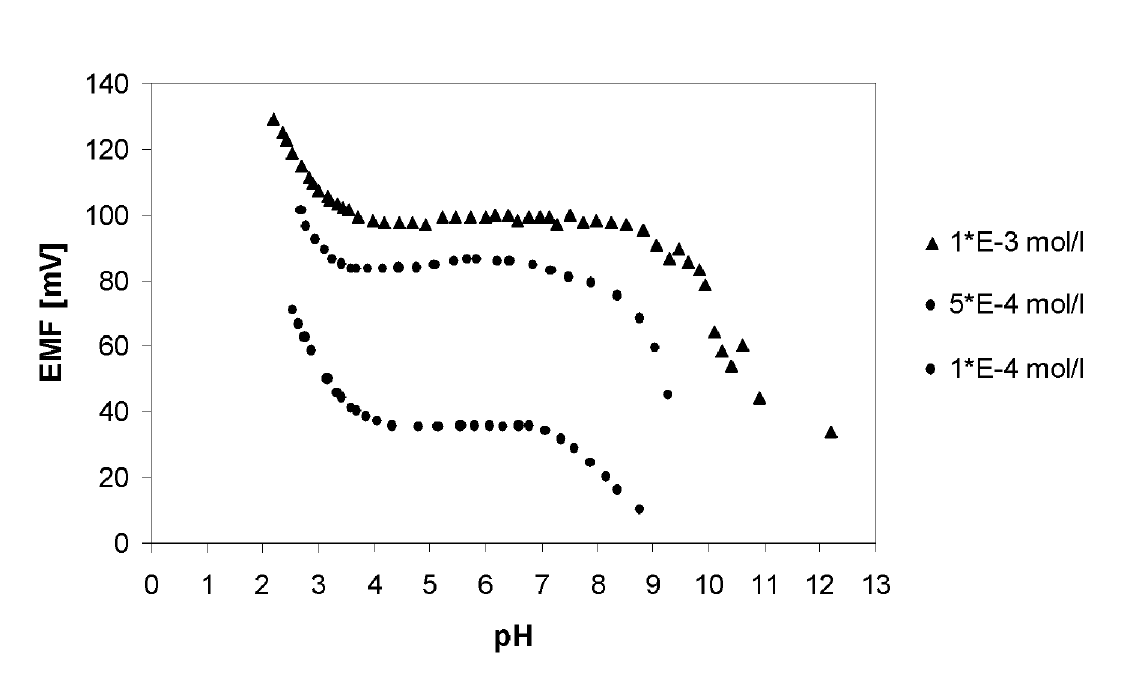
Fig. 3 E¬ect of pH on the labetalol electrode potential (labetalol hydrochloride